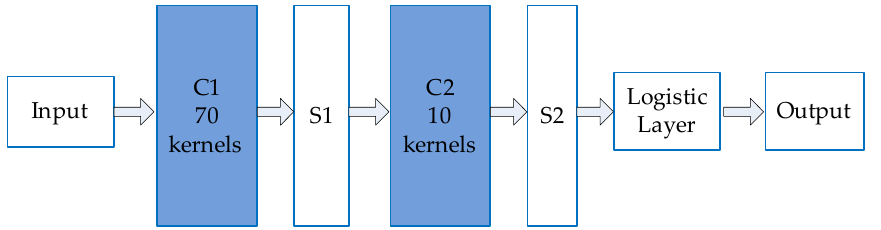
Figure 9. Structure of the simplified CNN. The size of the input image is a pixel size of 64 × 64 with RGB 3 channels. The output is one of the two category labels.